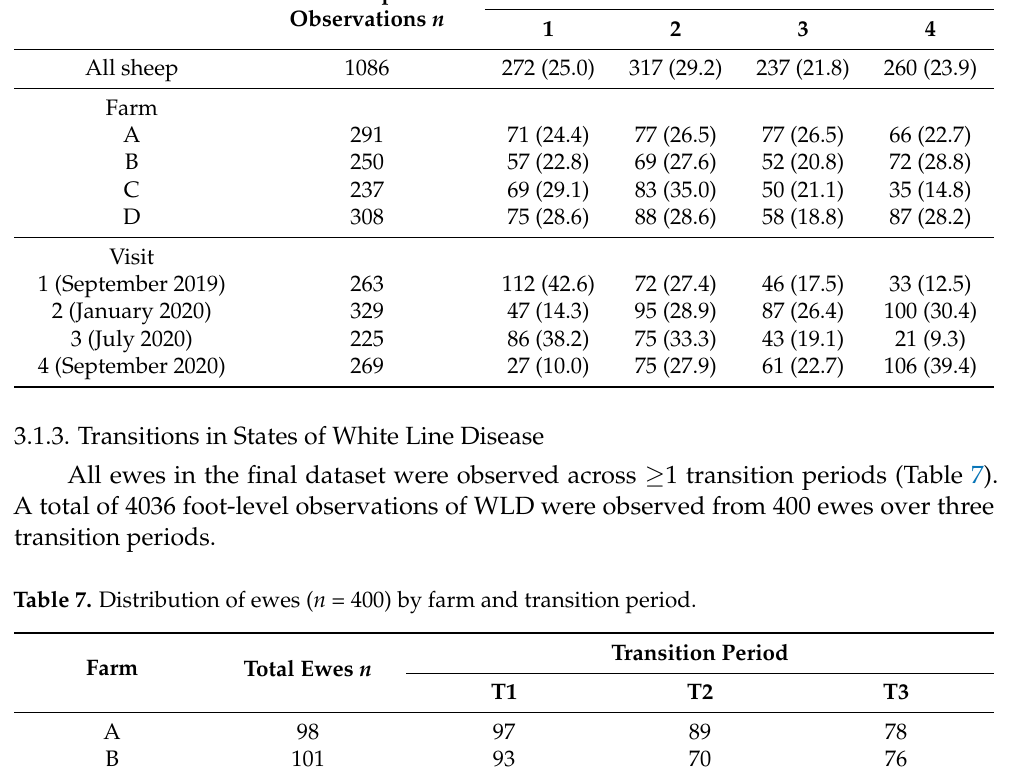
Table 6. Number of feet per ewe affected by white line disease for 1086 sheep-level observations of 396 ewes affected. Total Sheep-Level Observations n